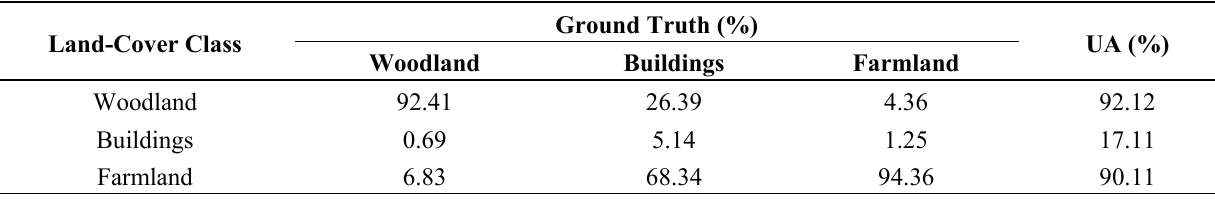
Table 7. The accuracy evaluation of the unsupervised classification result with the X-band InSAR image.